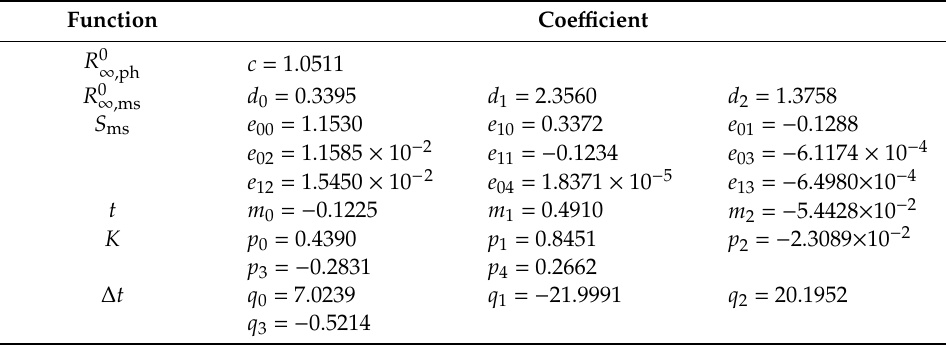
Table 1. The fitted coe ffi cients in the physical parameterization for single-layer water clouds. Function Coe ffi cient R 0 ∞ c = 1.0511 ,ph R 0 ∞ ,ms d 0 = 0.3395 d 1 = 2.3560 d 2 = 1.3758 S ms e 00 = 1.1530 e 10 = 0.3372 e 01 = − 0.1288 e 02 = 1.1585 × 10 − 2 e 11 = − 0.1234 e 03 = − 6.1174 × 10 − 4 e 12 = 1.5450 × 10 − 2 e 04 = 1.8371 × 10 − 5 m 0 = −